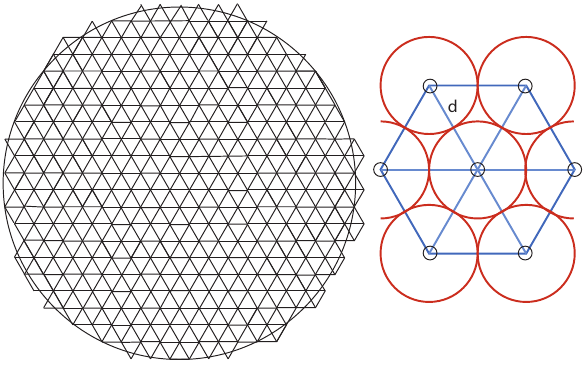
Fig. B2. Repulsive interaction between confined parallel field lines generates a hexagonal lattice composed of elementary flux tubes and magnetic field lines, each carrying just one flux quantum 8 0 = 2 π ¯ h/e . Every corner of a single hexagon is occupied by a field line, as shown on the right (small black circles of radius λ m ). If field lines are trapped, like in the frozen-in concept, then the number of field lines is roughly six times the number of hexagons which can be fitted into the cross section of an electron cyclotron orbit. The red circles indicate the repulsive quasi-potential barriers which build up around each field line as a result of the presence of the mutually interacting gauge fields (see below). The circular shape of these barriers holds approximately for nearest neighbor interactions only. The gauge fields of each field line are confined to their own circle. The open triangular regions between the red circular barriers are close to being free of any gauge